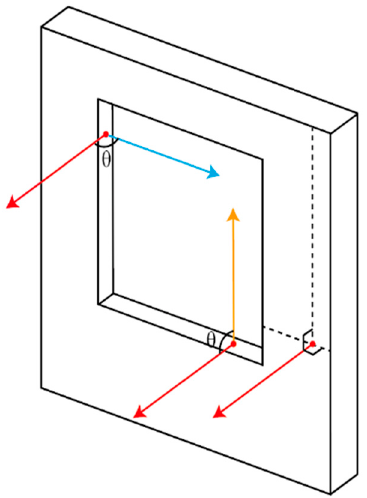
Figure 6. Normal vectors of the wall surfaces and sill ‐ like structure.